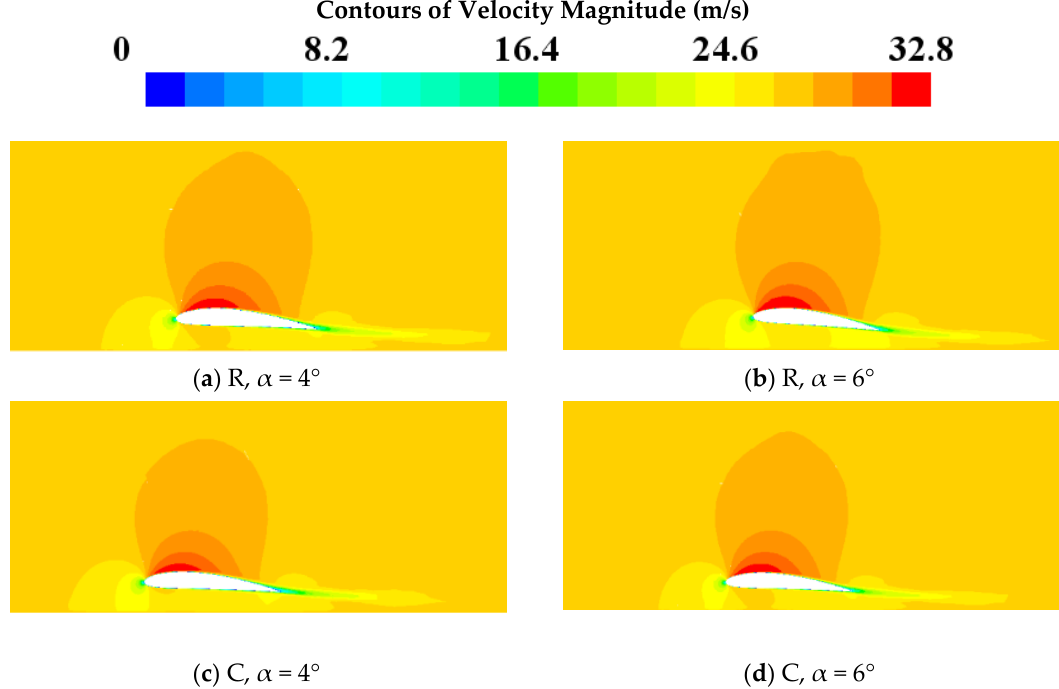
Figure 7. Velocity contours (m/s) at the middle span of the compound wing (C) and the rectangular wing (R) with h/c = 0.15 for various attack angles ( α ).